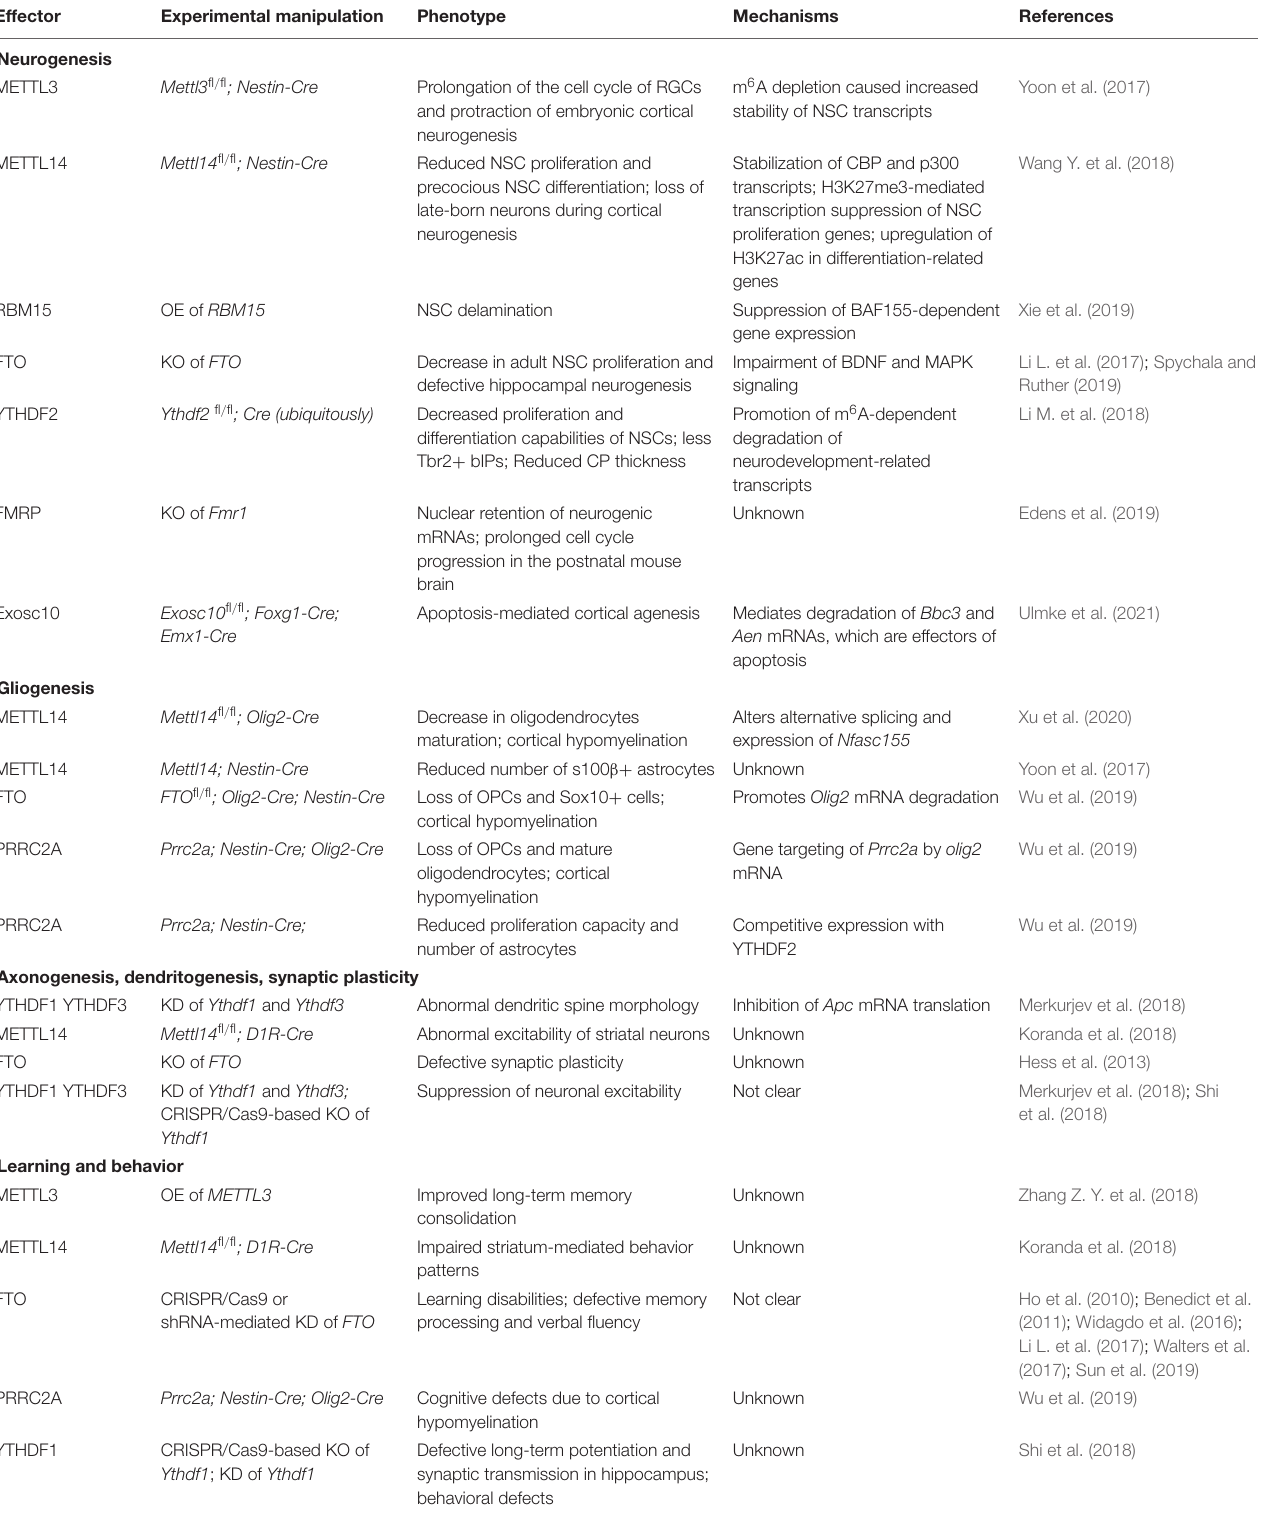
TABLE 1 | m 6 A mRNA methylation factors and their role in brain development and